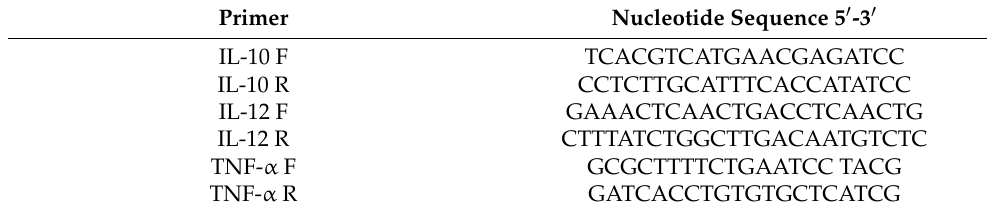
Table 1. Real-time qPCR primer